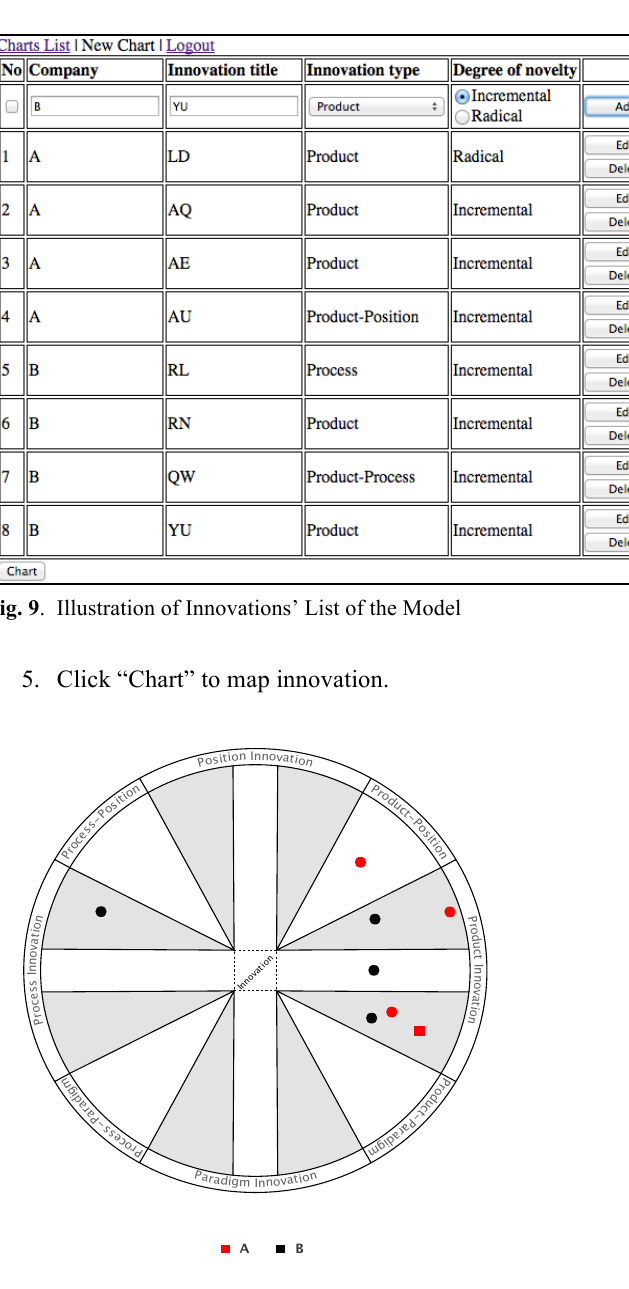
Fig. 10. Illustration of a Produced Chart of the Model Also, when the user hovers over innovations on the map, the description